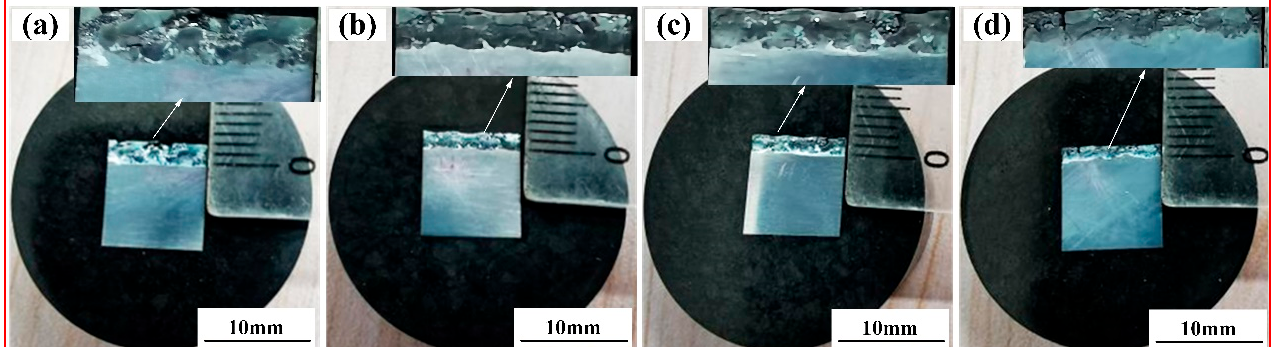
Figure 2. The effect of graphene content on the macroscopic morphology of the cladding layer: ( a ) 0% graphene mass fraction; ( b ) 0.5% graphene mass fraction; ( c ) 1.0% graphene mass fraction; ( d ) 1.5% graphene mass fraction.